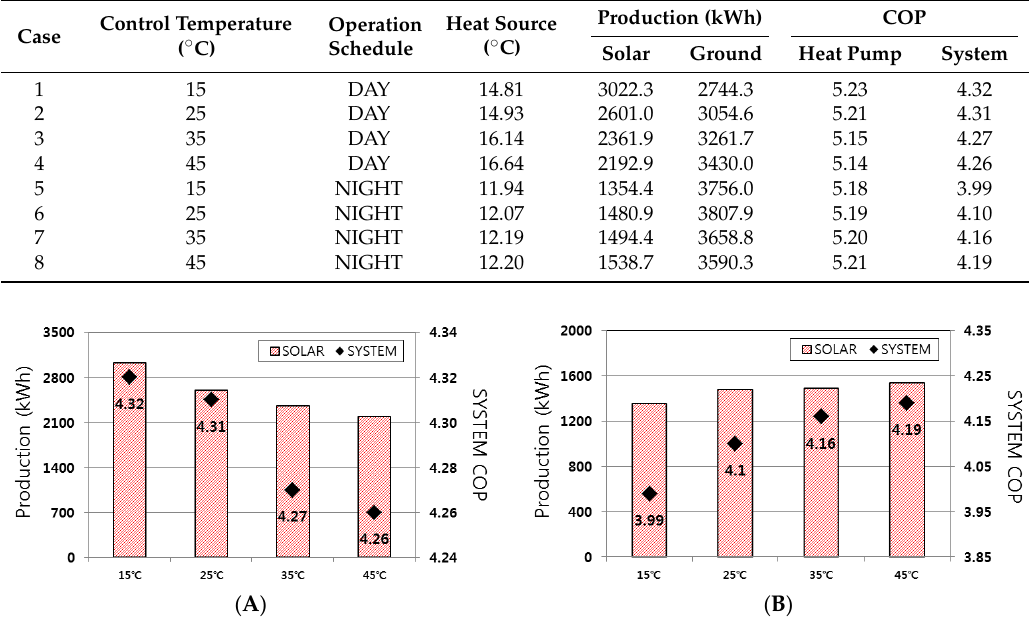
Figure 7. Solar heat production and COP according to the control temperature in SYSTEM 2. ( A ) Day; ( B ) Night.